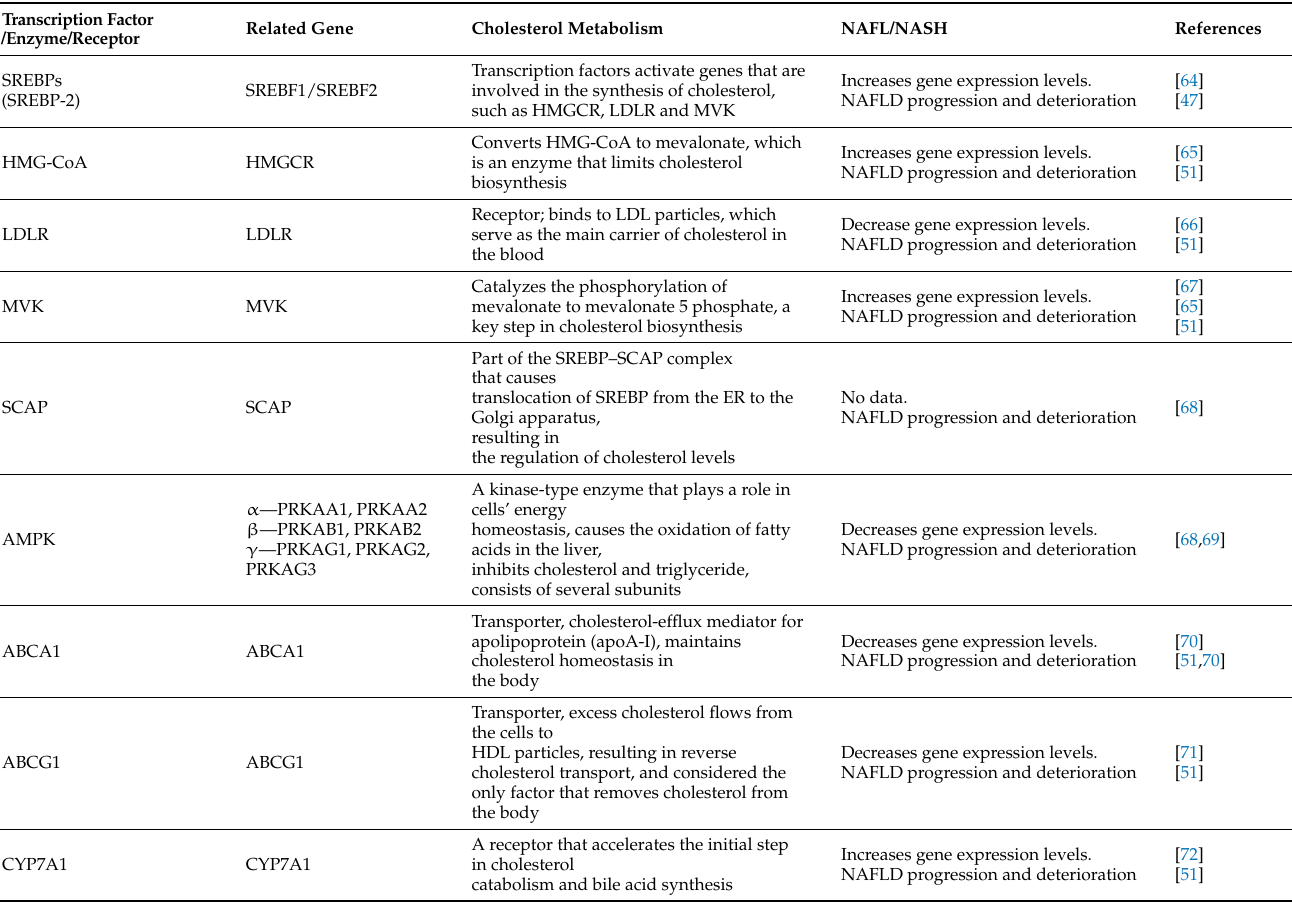
Table 1. Transcription factor, enzyme, receptors, and their associated genes involved in cholesterol metabolism and